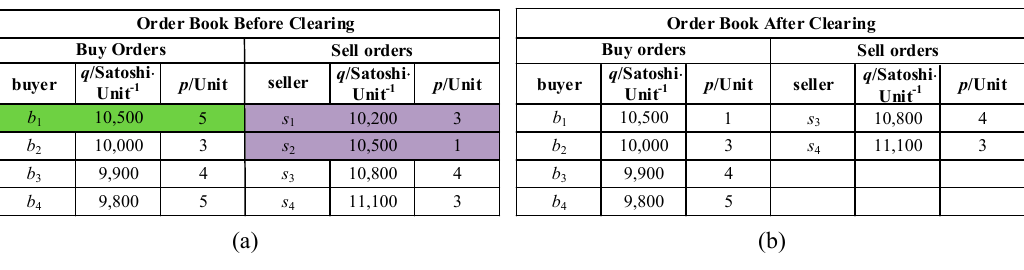
Figure 3. Order book in the CDA market. ( a ) order book before clearing (shaded area represents that the buyer and seller can match); ( b ) order book after clearing.